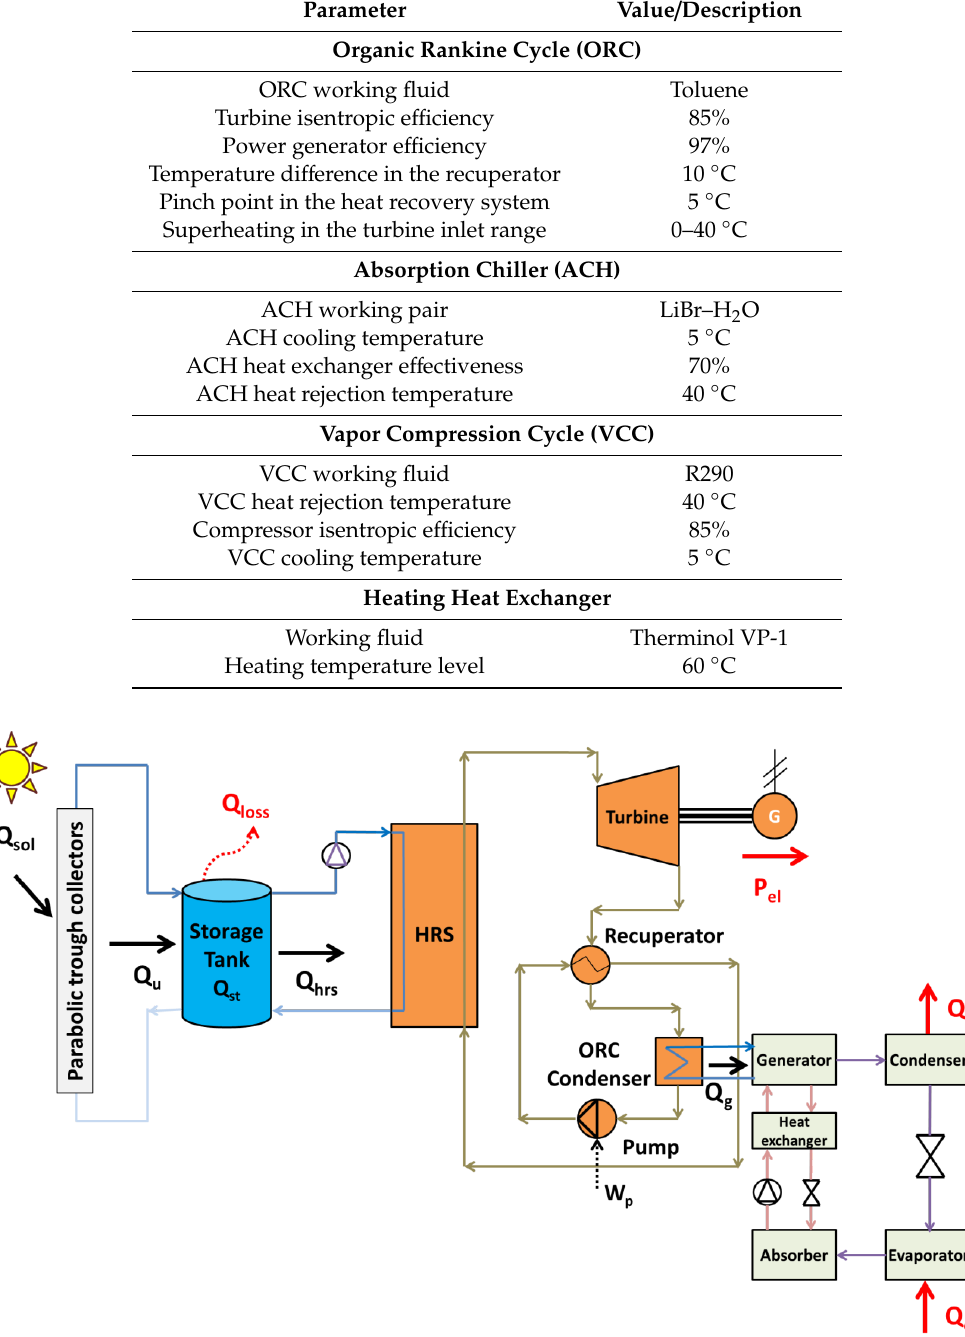
Figure 1. System 1 — The ORC feeds the ACH with heat. Figure 1. System 1—The ORC feeds the ACH with